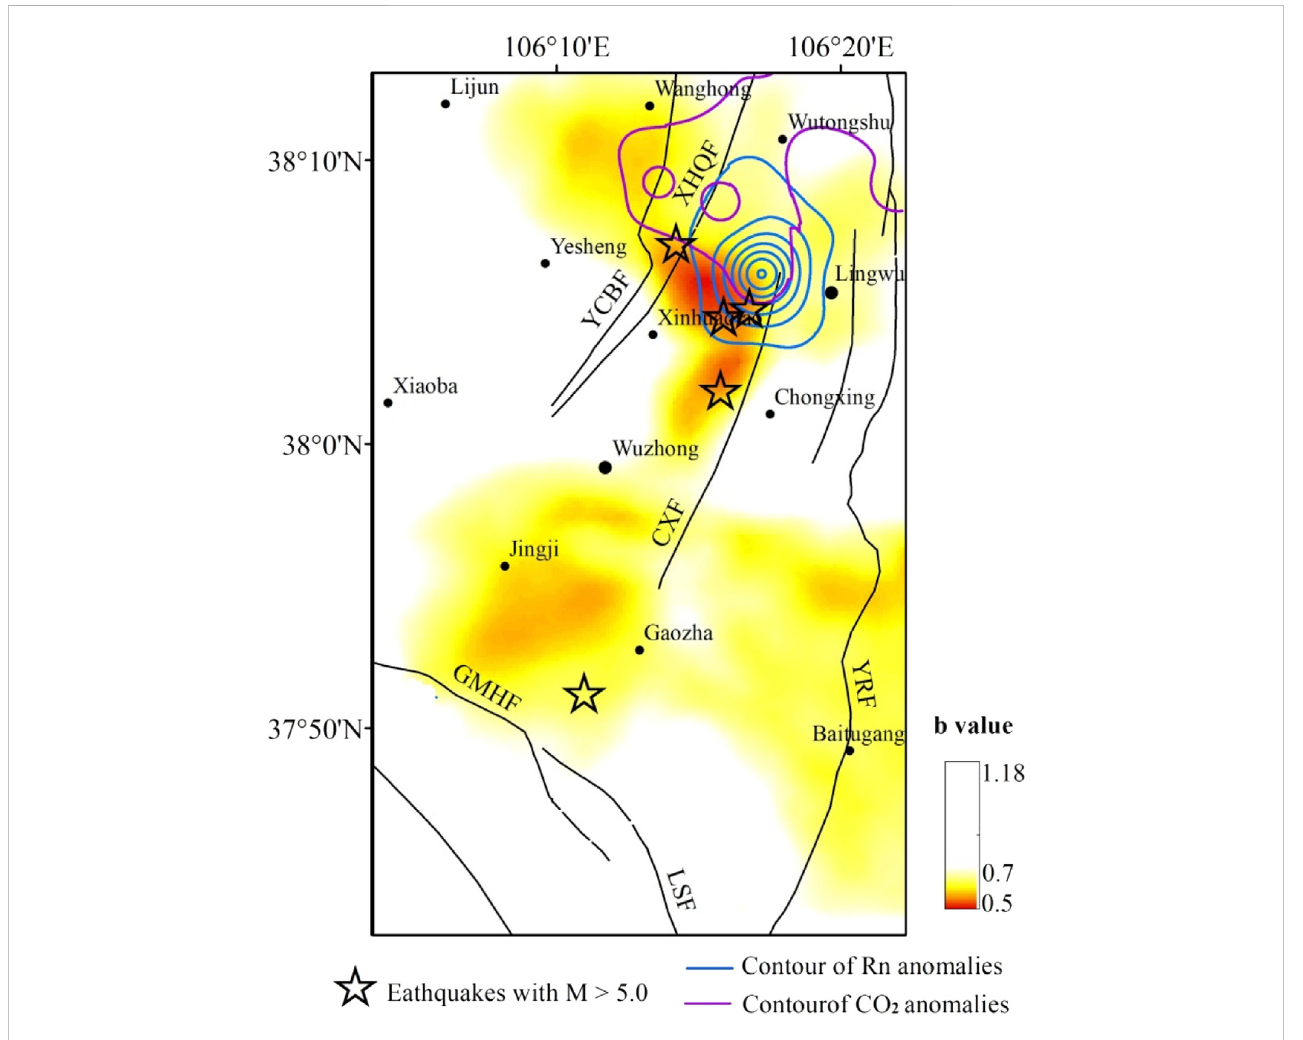
FIGURE 8 Spatial distributions of b-value and anomalies of gas in the Wuzhong – Lingwu area.